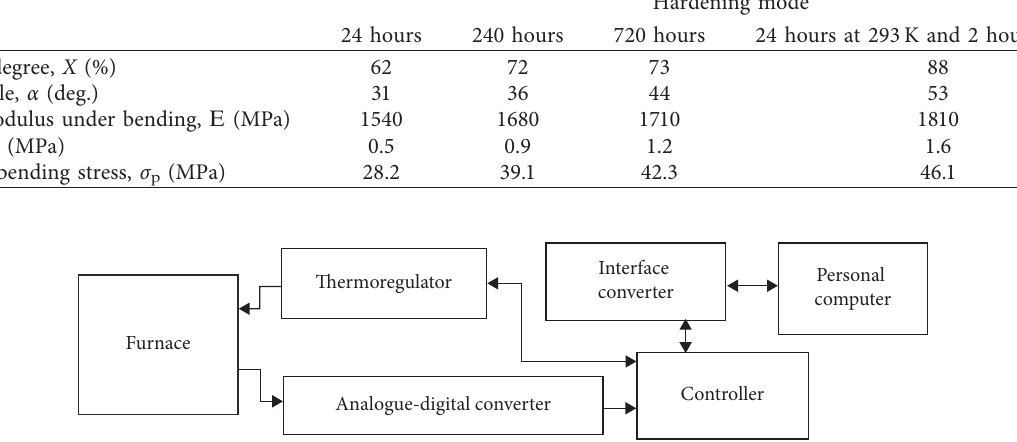
Table 1: The effect of hardening conditions on the binder properties based on ED-20.